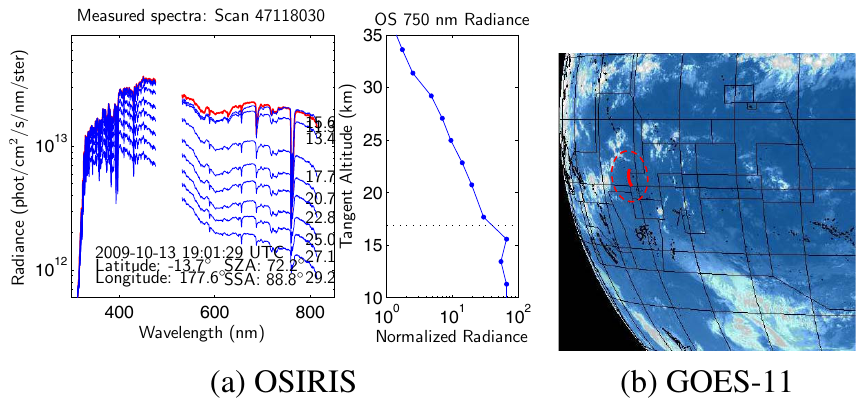
Fig. 1. (a) OSIRIS limb spectra and 750nm radiance profile from 13 October 2009, 19:01UTC; (b) concurrent GOES-11 10.7µm full-disk Fig. 1: (a) OSIRIS limb spectra and 750 nm radiance profile J.T. Wiensz: OSIRIS Thin Cirrus Retrievals image. from October 13, 2009, 19:01 UTC; (b) Concurrent GOES- 11 10 . 7 µ m full-disk image.